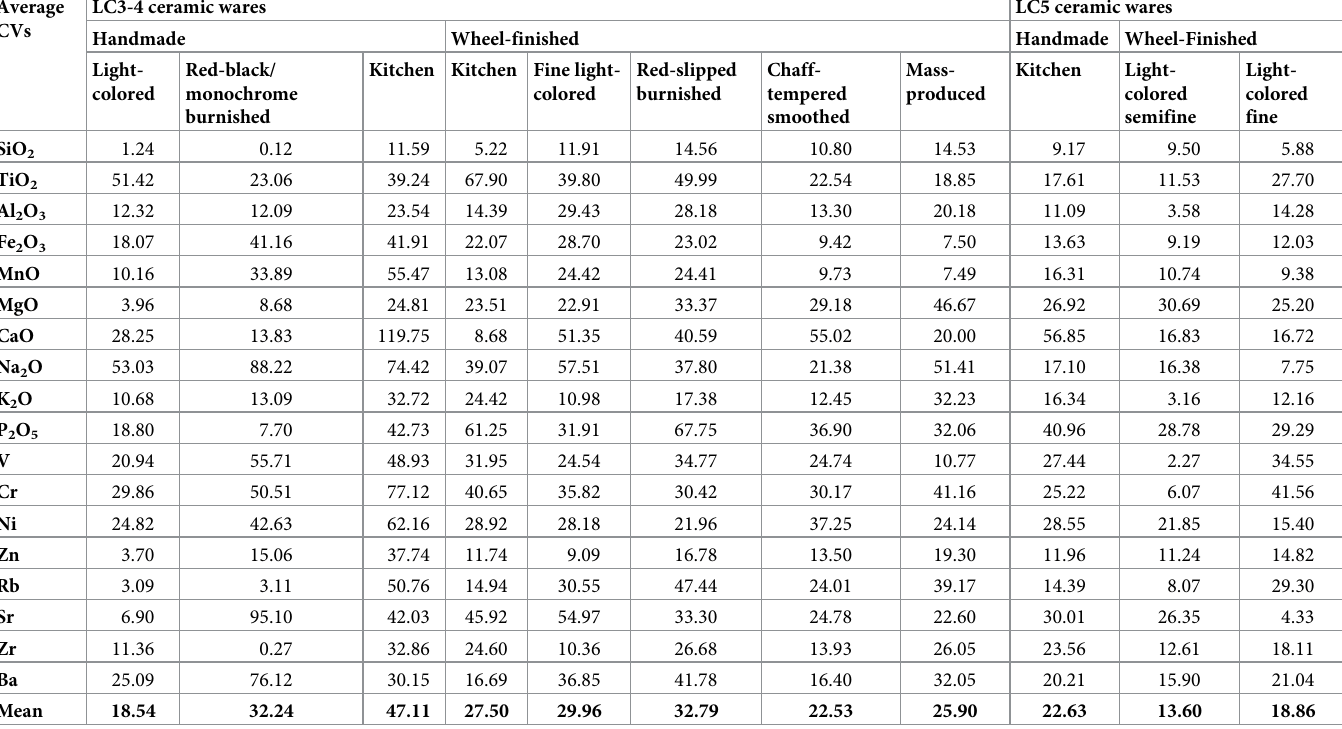
Table 8. Average CVs calculated on each element according to the different ceramic wares occurring in the LC3-4 and LC5